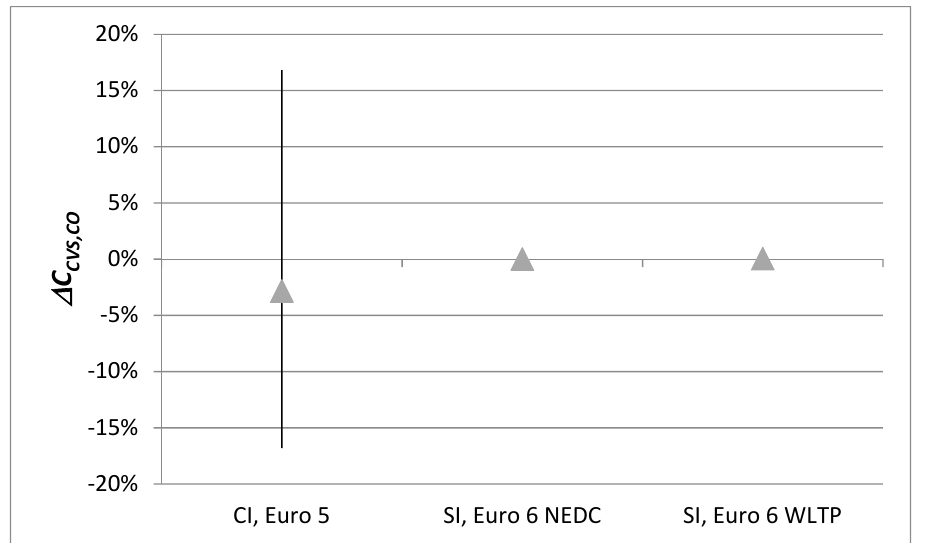
Figure 11. Relative percentage difference in determining the C CVS,corr concentration of the pollutant as calculated from dilution ratio DR (19) and dilution factor DF (3) for CO 2 .